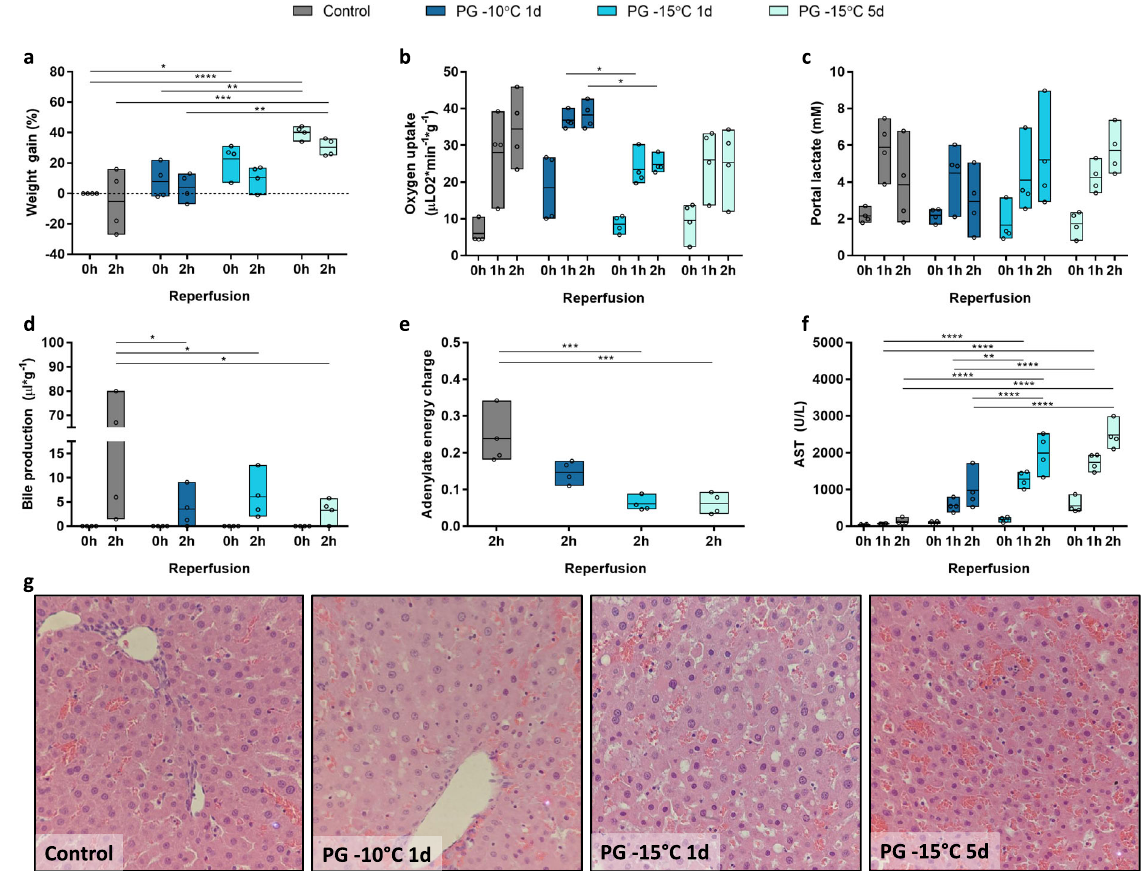
Fig. 3 Effect of storage temperature ( − 10 vs. − 15 °C) and duration of storage (1 vs. 5 days) on liver function, injury, and microscopic tissue structure after partial freezing with propylene glycol. a Weight gain as percentage of the procurement weight. b Oxygen uptake. c Lactate concentration in the portal vein. d Bile production. e Tissue adenylate energy charge. f Aspartate aminotransferase concentration (AST) in the IVC. g Light microscopy images of parenchymal liver wedges at the end of simulated transplantation (×40). Controls (gray) = 1 day hypothermic preservation, PG = propylene glycol stored for 1 day at − 10 °C (dark blue), 1 day at − 15 °C (blue), and 5 days at − 15 °C (light blue). Stars denote statistical signi fi cance (two-way ANOVA, followed by Tukey ’ s post-hoc test): *0.01 < p < 0.05; **0.001 < p < 0.01; ***0.0001 < p < 0.001; **** p < 0.0001. Boxes: Floating bars (min to max), with a line at the mean. Source data are provided as a Source Data fi